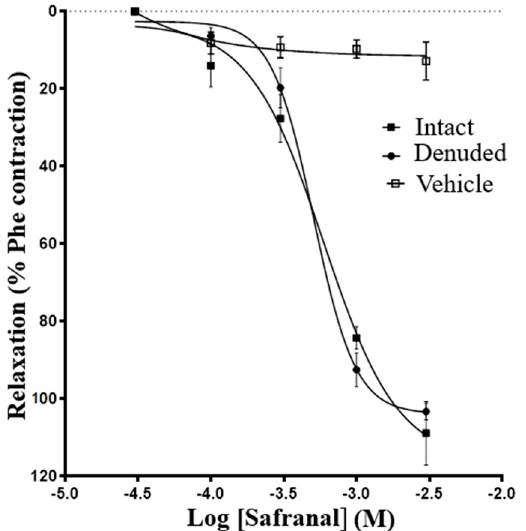
Figure 1. Safranal-induced vasorelaxation in endothelium-intact and endothelium-denuded aortic rings precontracted with phenylephrine. The vasodilatory effect of safranal is expressed as a percentage of vasodilation to maximum contraction induced by 5 × 10 − 5 M Phe in the intact endothelium (solid circles, n = 14) and the denuded endothelium (solid squares) rings. The solvent (Tween 80, open circles, n = 10) caused negligible vasorelaxation. Values are expressed as means ± SEM. Table 1. IC 50 for safranal and acetylcholine on denuded and intact isolated thoracic aortic rings a .